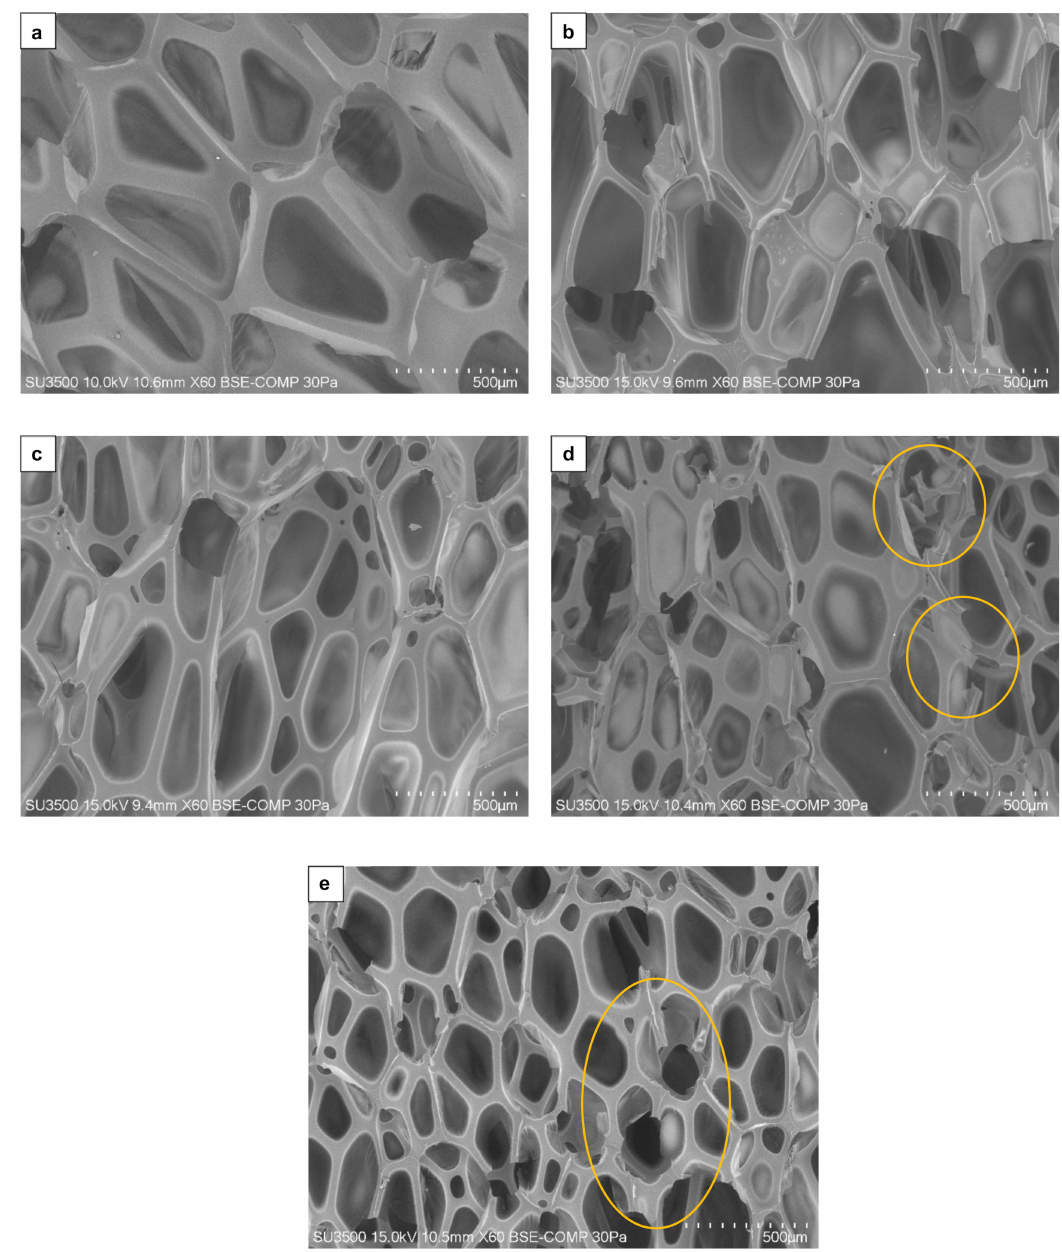
Figure 3. SEM images of PUR-WP composite structure: ( a ) reference sample; ( b ) 0.05–<0.125 mm; ( c ) 0.125–<0.315 mm; ( d ) 0.315–1.25 mm; ( e ) >1.25–2.0 mm. Cracks are marked with yellow